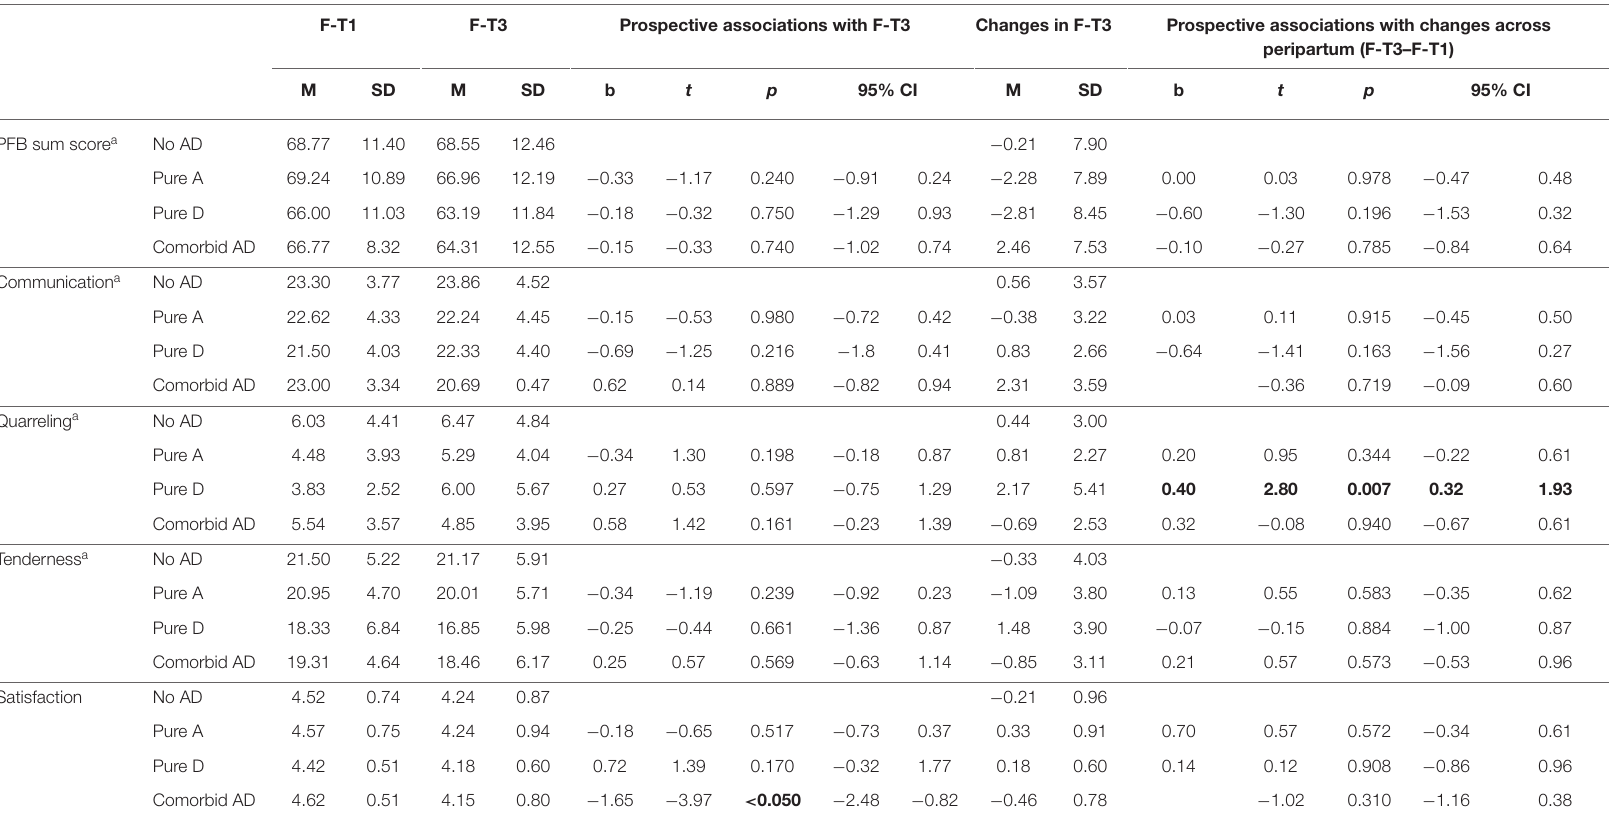
TABLE 2 | Prospective associations of paternal psychopathology with paternal partnership quality and changes across peripartum. F-T1 F-T3 Prospective associations with F-T3 Changes in F-T3 Prospective associations with changes across